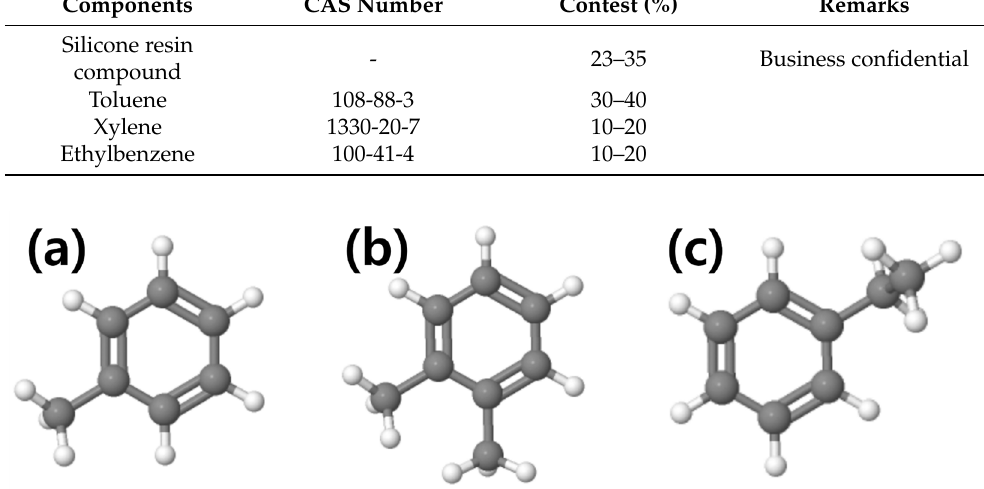
Table 3. Silicon resin composition table.